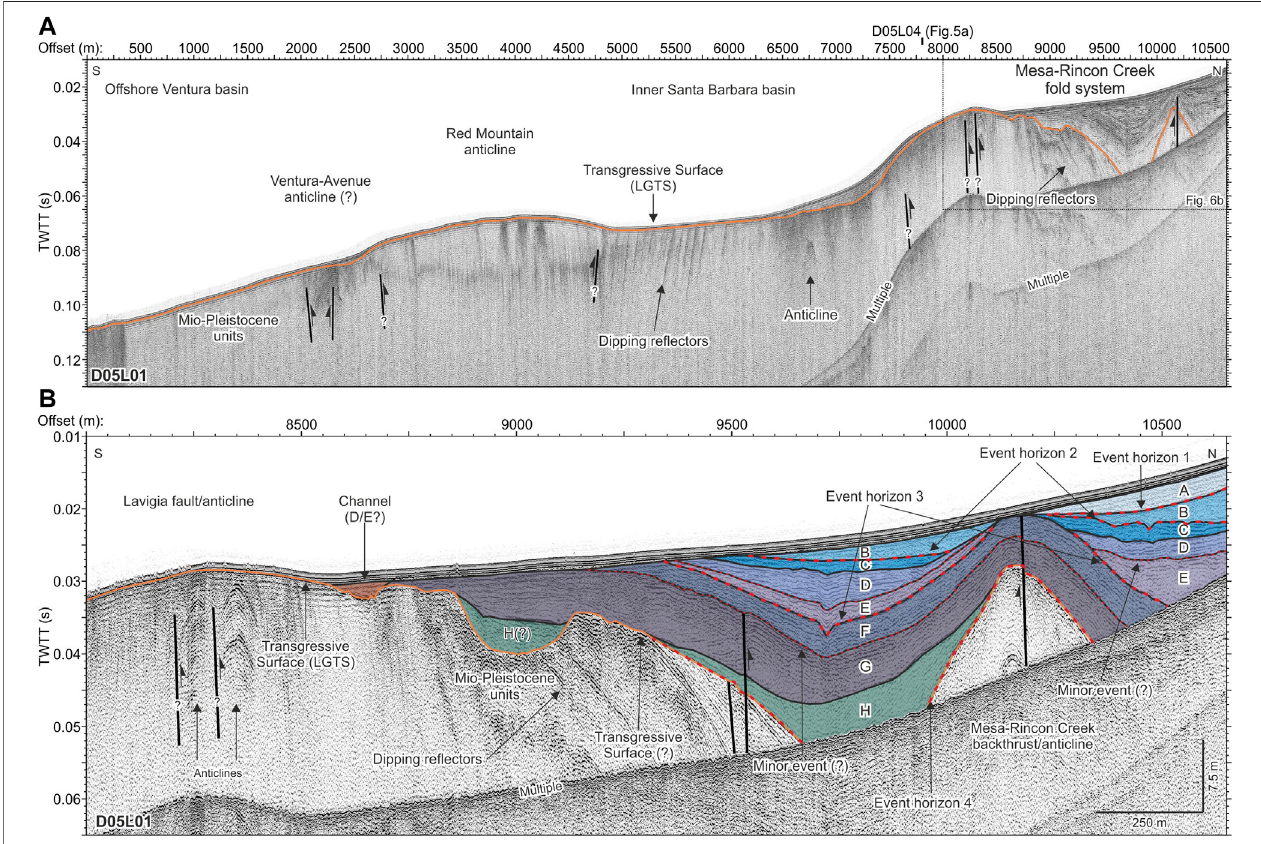
FIGURE 6 | (A) Interpreted CHIRP strike pro fi le D05L01 showing the folding of the Last Glacial transgressive surface (LGTS; continuous orange line) related to the Mesa-Rincon Creek fold system and offshore Red Mountain anticline. Note that the anticline that is interpreted as the potential Ventura-Avenue anticline is folding the Mio-Pleistocene units, but not the LGTS. The location of the pro fi le is shown in Figures 2 , 3 . (B) Enlarged section is shown by rectangle in Figure 6A highlighting the intensefoldingoftheLGTS(orangecontinuousline)relatedtotheMesa-RinconCreekfoldsystem.Differentseismostratigraphicunits(A – H)areidenti fi edbasedon stratal geometry. The red dashed lines identify horizons corresponding to different deformation events (i.e., inferred earthquakes). Uninterpreted pro fi les are provided in Supplementary Figure S6 .